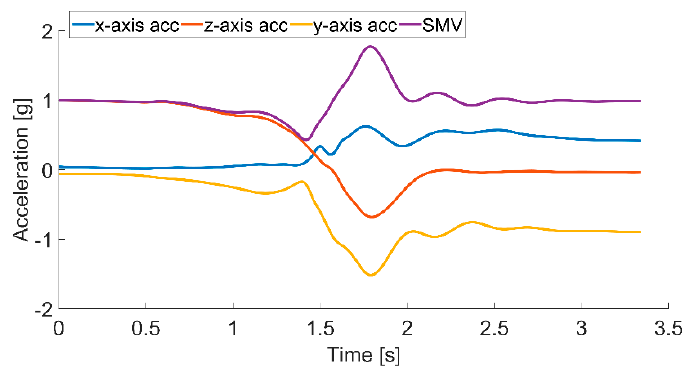
Figure 11. Forward fall test: accelerations in x -, y - and z -axis and SMV characteristic.